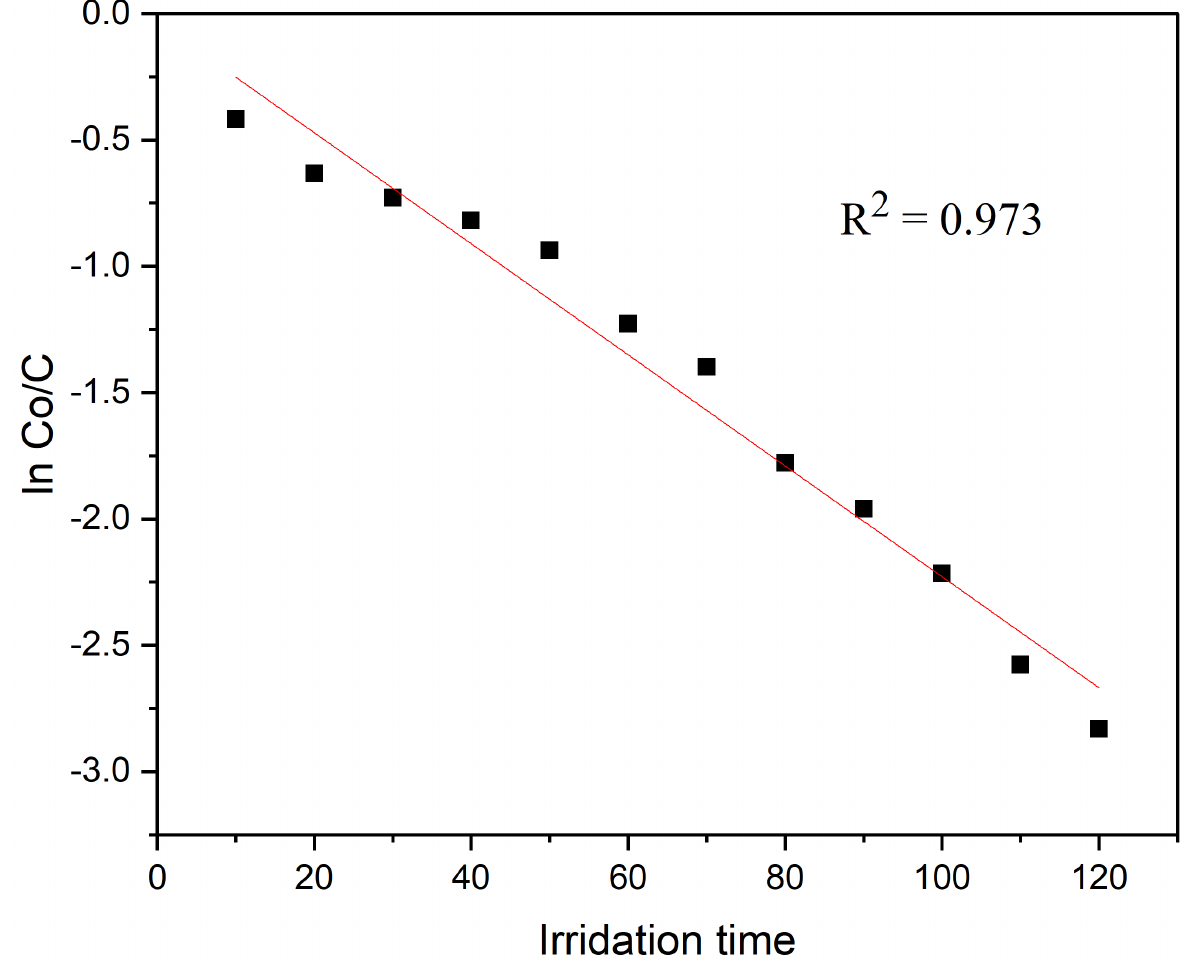
Figure 7. Kinetic rate constant for the degradation of CR dye.